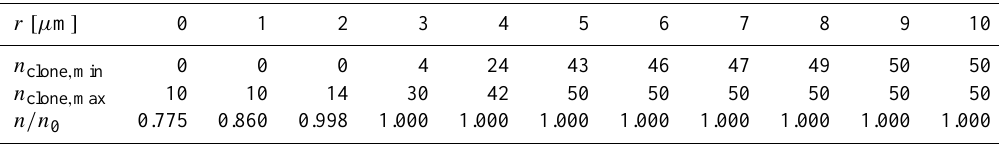
Table 2. Minimum and maximum number of particle clones ( n clone , min , n clone , max ) among the n 0 particles depositing within 2 . 5 days for Fig. 7. The statistics of the root-mean-square clone distances d air , hor and d dep , hor in horizontal (a) and d air , vert particle radius r . n denotes the number of particles having at least two clones being deposited over 2 . 5 days. in vertical (b) of the particles in the 50 ensemble members after 2.5 days averaged over the particles that remain in the atmosphere (blue) or deposit (red). Minima and maxima (horizontal line segments), lower and upper r [ µ m ] quartiles (the bottom and the top of the boxes), and medians (horizontal lines in the boxes) are plotted.